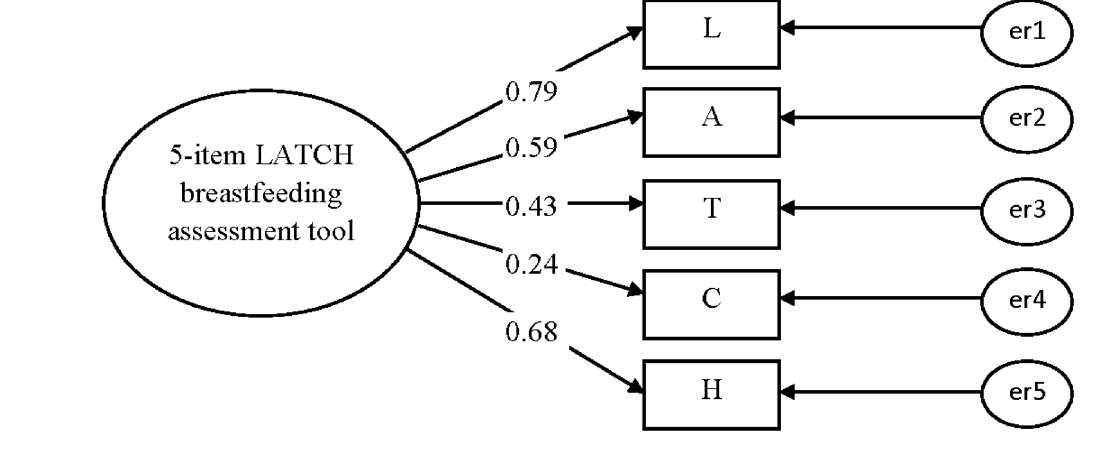
Fig 1. Confirmatory factor analysis for the 5-item LATCH breastfeeding assessment tool among vaginally delivered women (n = 335). Fit indices: GFI=0.980; AGFI=0.941; IFI=0.957; TLI=0.913; CFI=0.956; RMSEA=0.086.